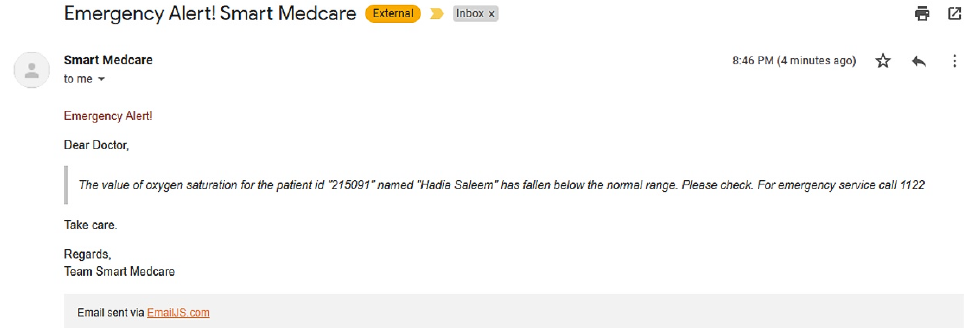
Figure 13. Graphical representation of real-time data on the website.